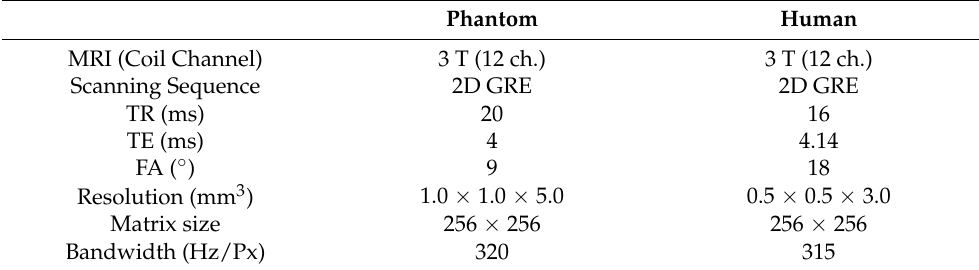
Table 1. MR parameters for cerebral-artery PWV.